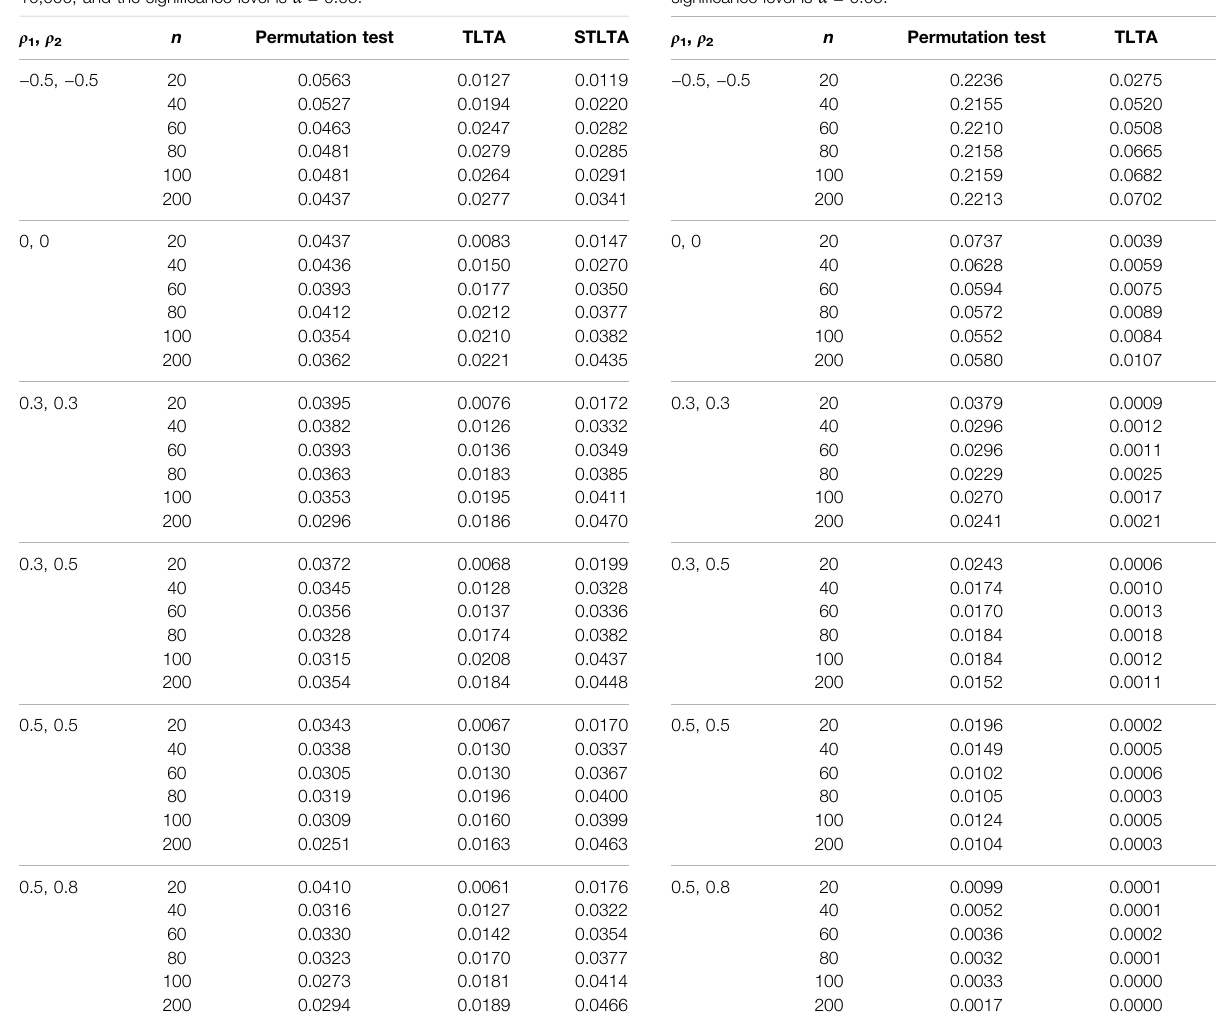
TABLE 3 | Type I error rate for different methods (the third to fi fth columns) in the ARMA(1,1)-TAR(1) model when t = 0. The fi rst and second columns represent different combinations of autoregressive coef fi cients and sample sizes. The number of permutation tests is 1,000, the number of repeated simulations is 10,000, and the signi fi cance level is α = 0.05.